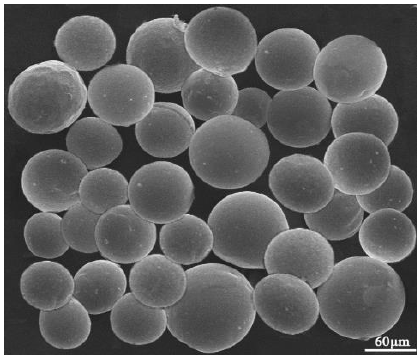
Table 2. Chemical composition of the Ni60 alloy powder (wt.%).